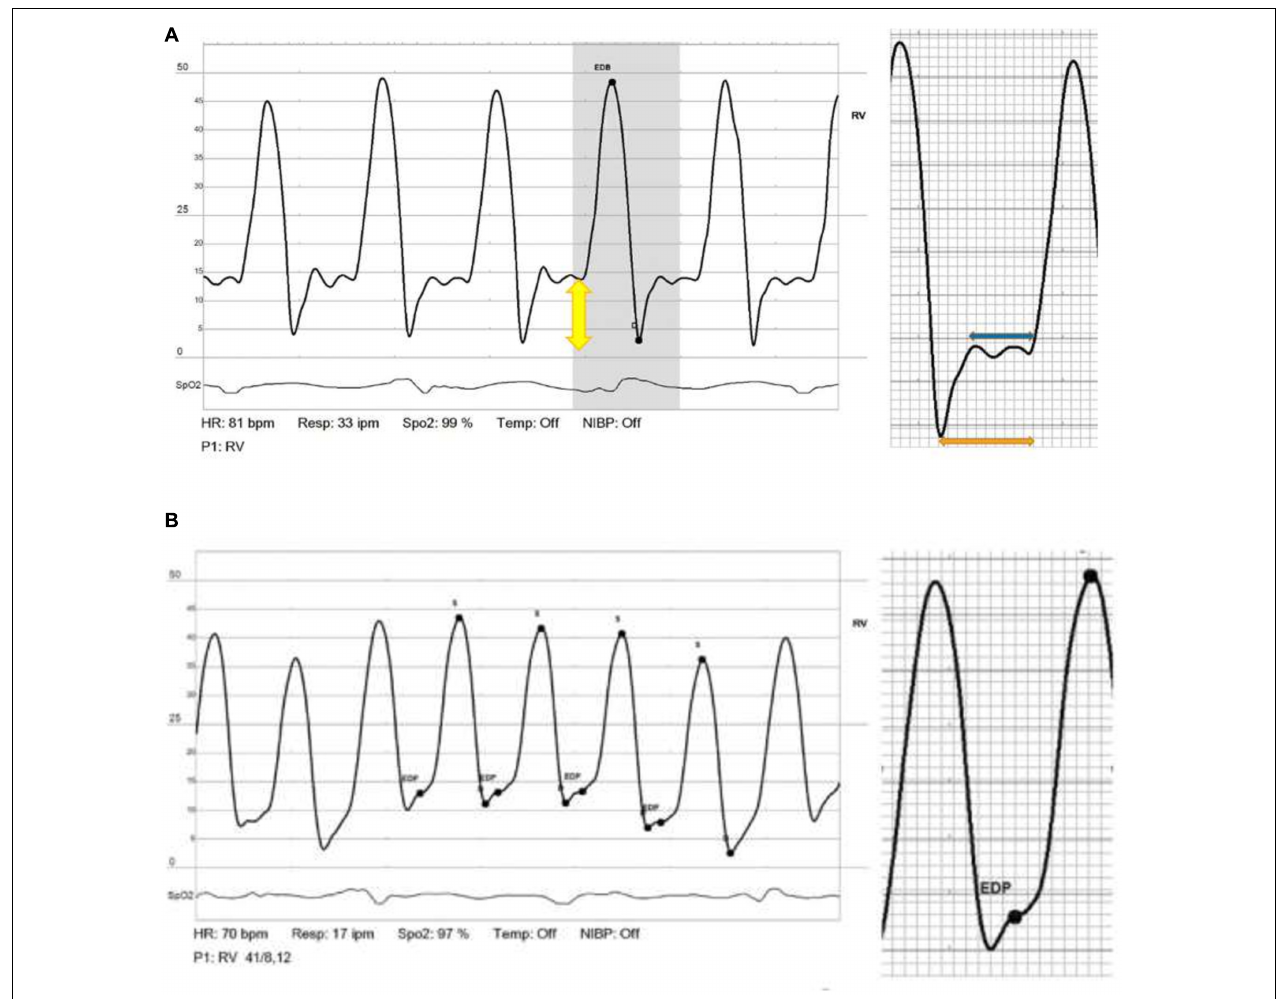
FIGURE 1 | (A) Positive diastolic plateau. (B) Normal right heart tracing with no diastolic plateau.